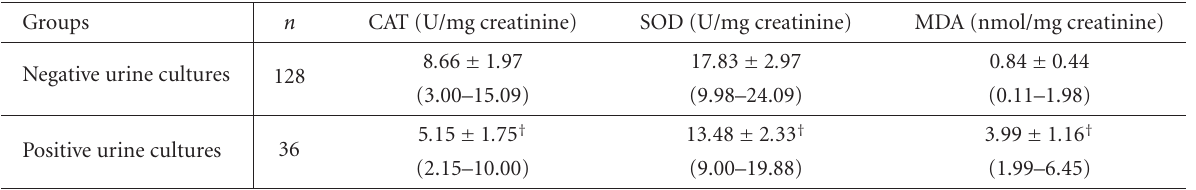
Table 1. Catalase, superoxide dismutase, and malondialdehyde levels in positive and negative urine cultures. † denotes values signifi- cantly di ff erent from negative urine cultures values; P < . 01. Values were expressed as mean ± SDs. Groups n CAT (U/mg creatinine) Negative urine cultures Positive urine